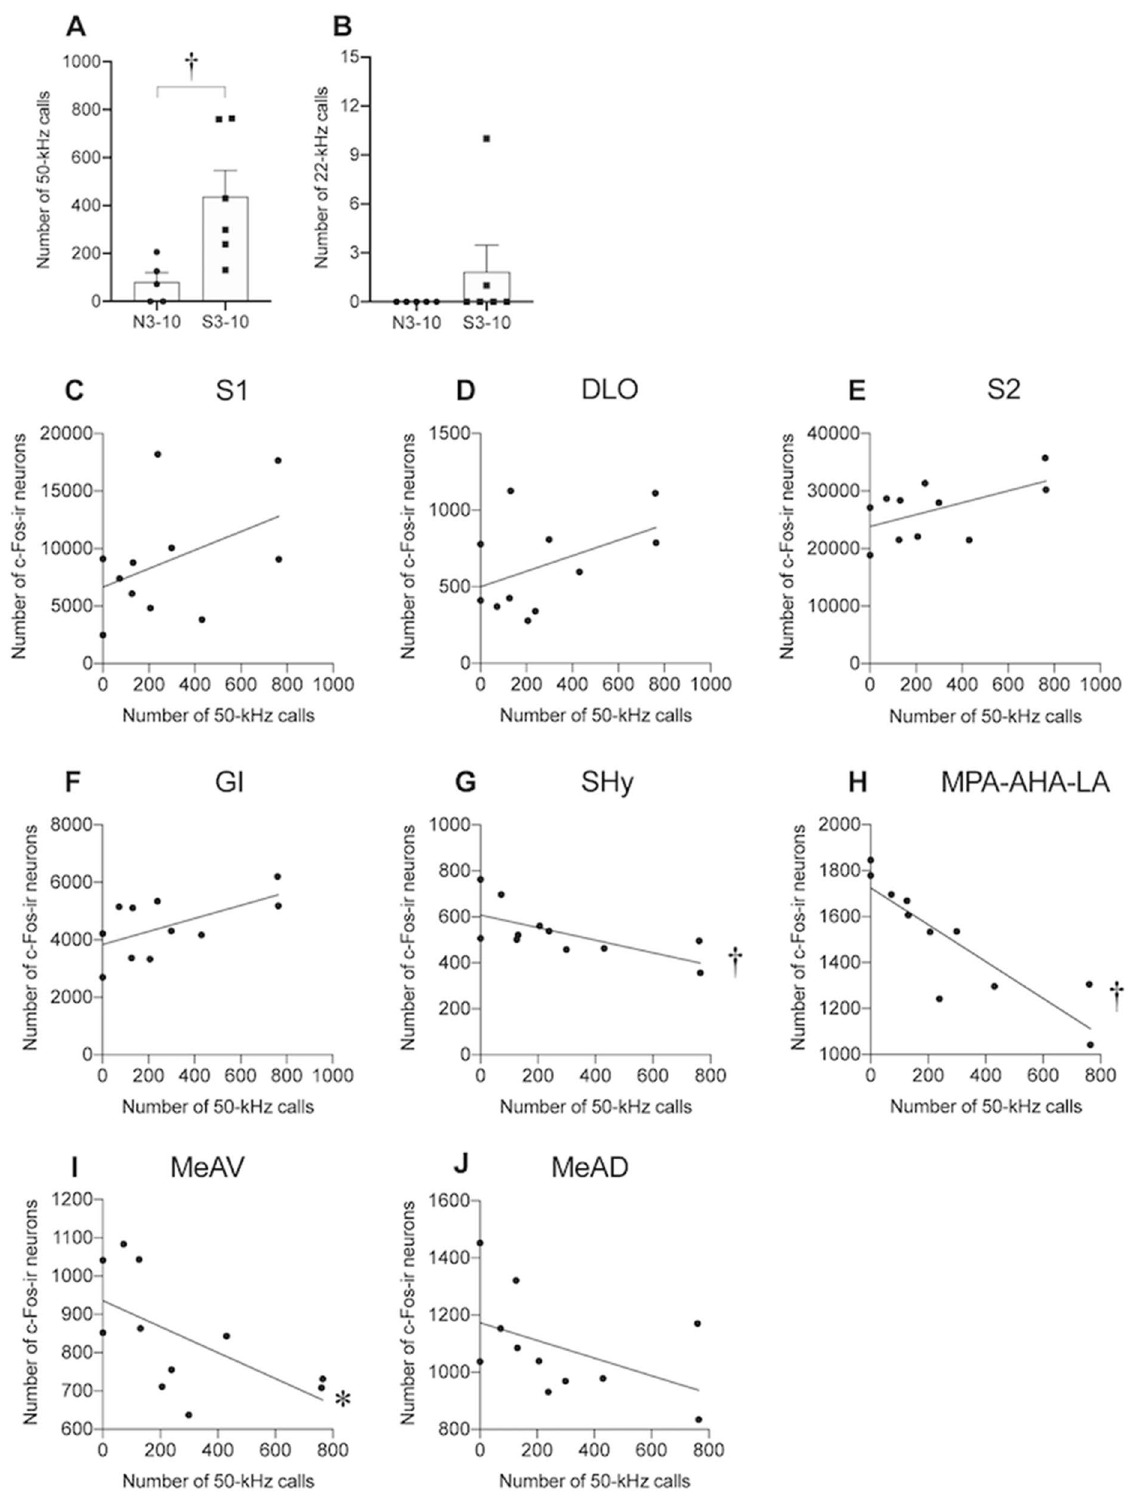
Figure 8. Number of ultrasonic vocalizations and correlation between number of c-Fos-ir cells and number of 50-kHz calls. ( A , B ) Numbers of 50-kHz calls ( A ) and 22-kHz calls ( B ) during stroking stimuli before brain sampling. ( C – J ) Correlations between numbers of c-Fos-ir neurons in the primary somatosensory cortex (S1) ( C ), dorsolateral orbital cortex (DLO) ( D ), secondary somatosensory cortex (S2) ( E ), granular insular cortex (GI) ( F ), septhohypothalamic nucleus (SHy) ( G ), medial preoptic area (MPA)-anterior hypothalamic area (AHA)-lateroanterior hypothalamic area (LA) ( H ), medial amygdaloid nucleus anteroventral part (MeAV) ( I ), and medial amygdaloid nucleus anterodorsal part (MeAD) ( J ) and number of 50-kHz calls during stroking stimuli. In the SHy, MPA-AHA-LA, and MeAV, there were significant negative correlations. †, P < 0.01, *, P < 0.05. Spearman’s correlation